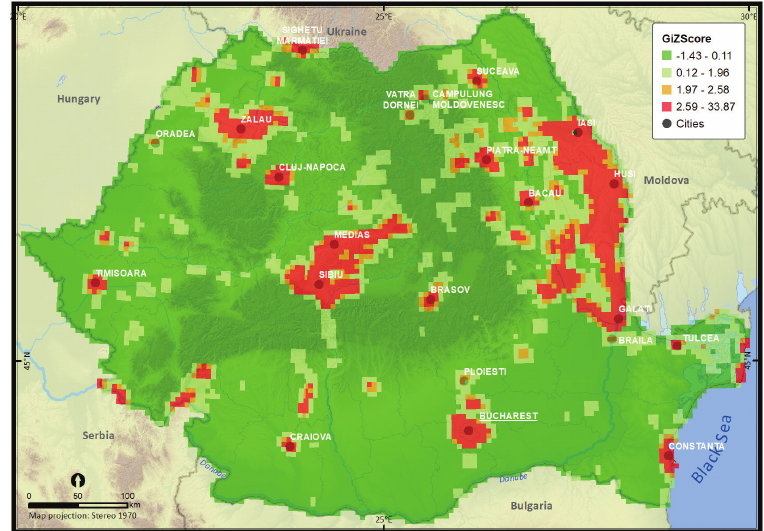
Figure 4. Hotspots of invasive and potentially invasive alien plant species sampling in Romania (in red). The p-value was < 0.05 when Z scores took values between 1.96 and 33.87, suggesting a highly clustered pattern in the number of IAP species occurrences per UTM 5 × 5 km grid cell.